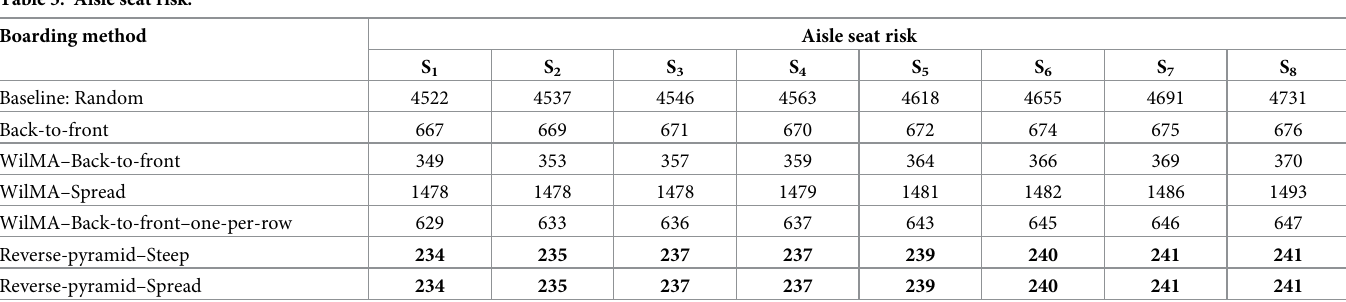
Table 3. Aisle seat risk.